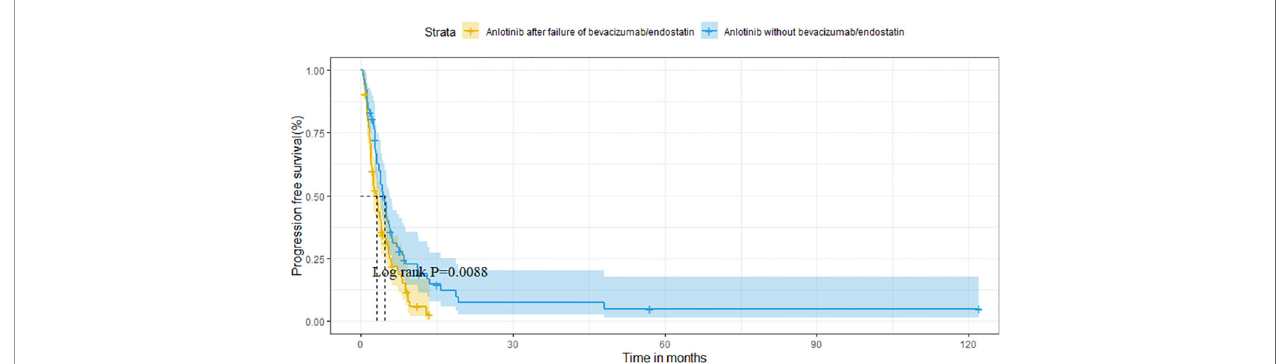
FIGURE 3 | Comparison of PFS between the two groups.